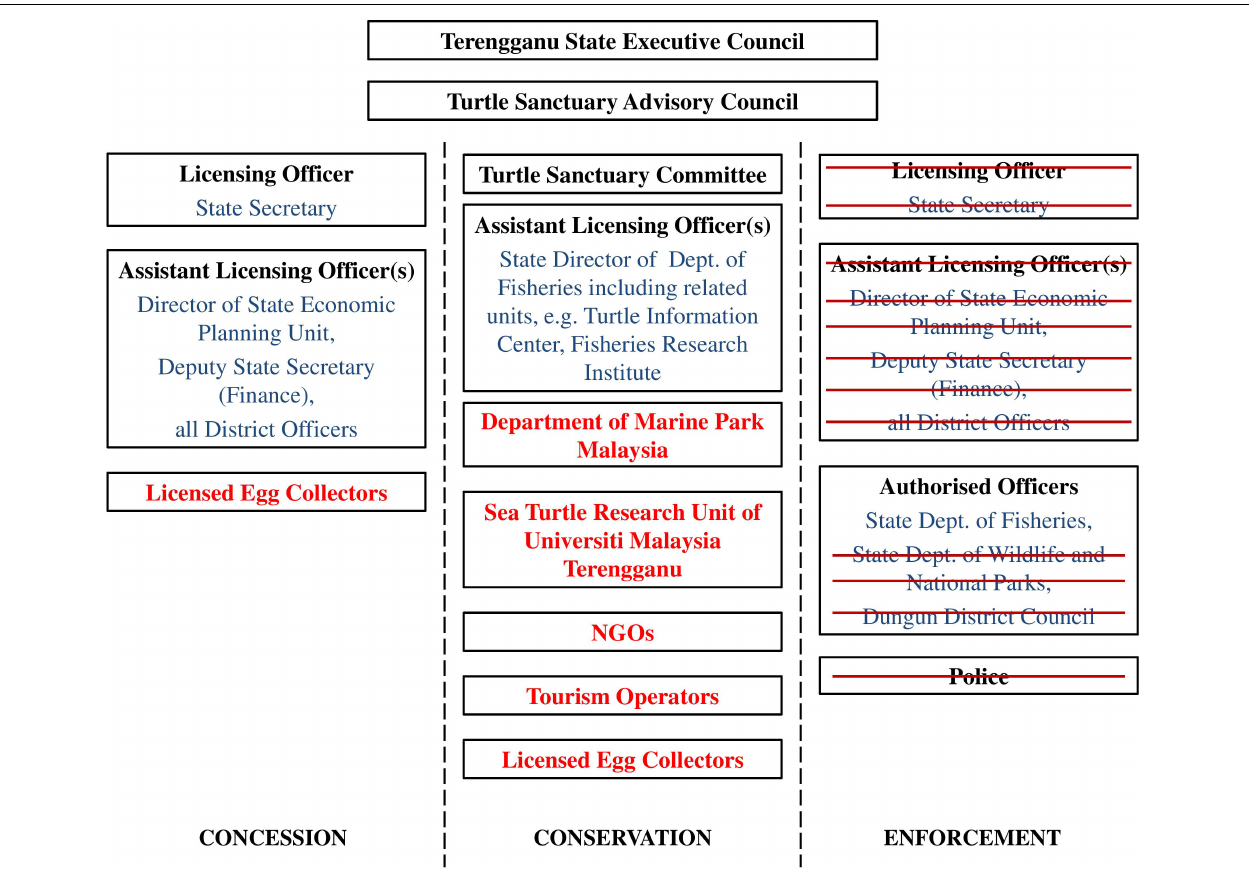
FIGURE 4 | Institutional framework for sea turtle management in Terengganu based on what is practiced in reality, showing the institutions and their appointees (in blue) according to their roles in sea turtle egg concession, conservation, and enforcement. Those crossed in red are structures or agencies that are in reality found absent or not carrying out their roles. Institutions (in red), not provided in the legal institutional, but are added for their role in sea turtle